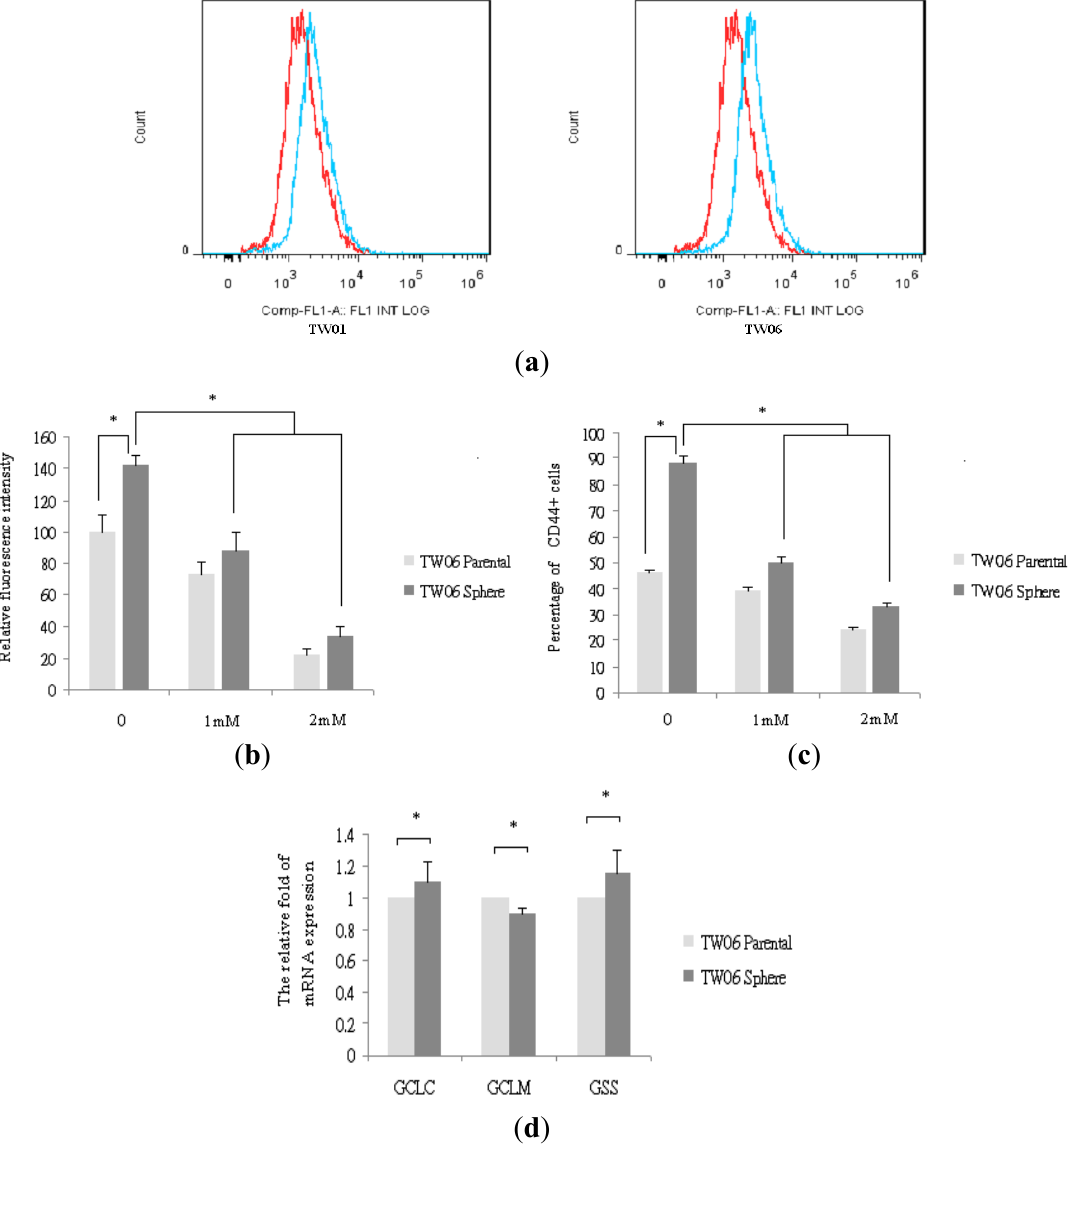
Figure 4. Redox status in NPC sphere-derived cells is associated with CD44 and EMT marker expression. ( a ) The levels of ROS were higher in the sphere-derived cells than in the parental cells. Red, parental cells; blue, sphere-derived cells; ( b ) The levels of ROS reduced significantly in the TW06 sphere-derived cells after the addition of NAC, as shown by DCF-DA staining, * p < 0.05; ( c ) The expression of CD44 reduced significantly in the TW06 sphere-derived cells after the addition of NAC, * p < 0.05; ( d ) The expression of GCLC, GCLM, and GSS mRNA showed non-significant differences in the TW06 sphere-derived cells and parental cells, * p > 0.05; ( e ) NAC treatment reduced the levels of N-cad, VIM, and snail mRNA in the TW06 sphere-derived cells. Data are presented as mean ± SD. * and # indicate significant differences from the respective controls, p < 0.05; ( f ) NAC treatment increased the expression of E-cad in the TW06 sphere-derived cells, * p <